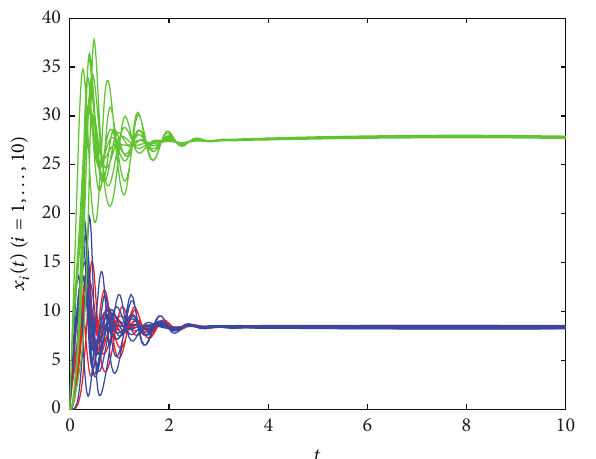
Figure 2: Control results of the network when 𝑐 = 3 , 𝑑 1 = 𝑑 7 = = 3 , and 𝑑 = 0.015 . 𝑑 9